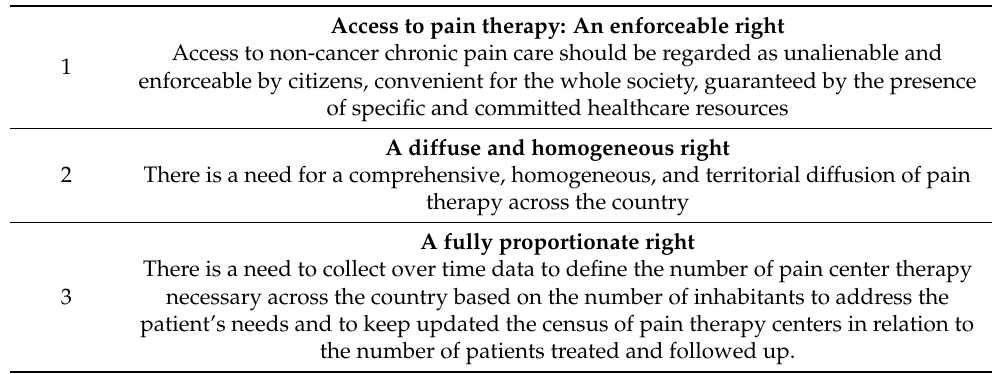
Table 2. Social Manifesto against pain [23]. Reproduced with the permission of